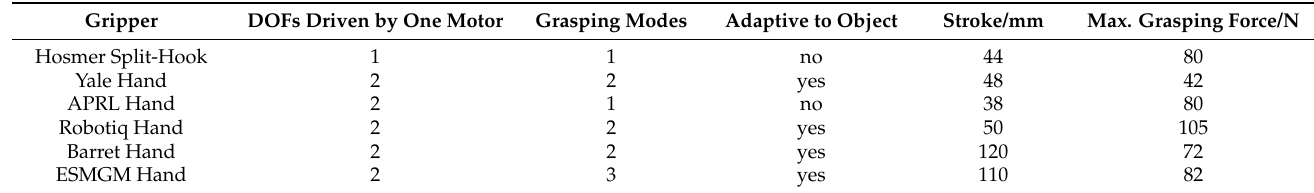
Table 5. Grasping performance of the ESMGM hand and other